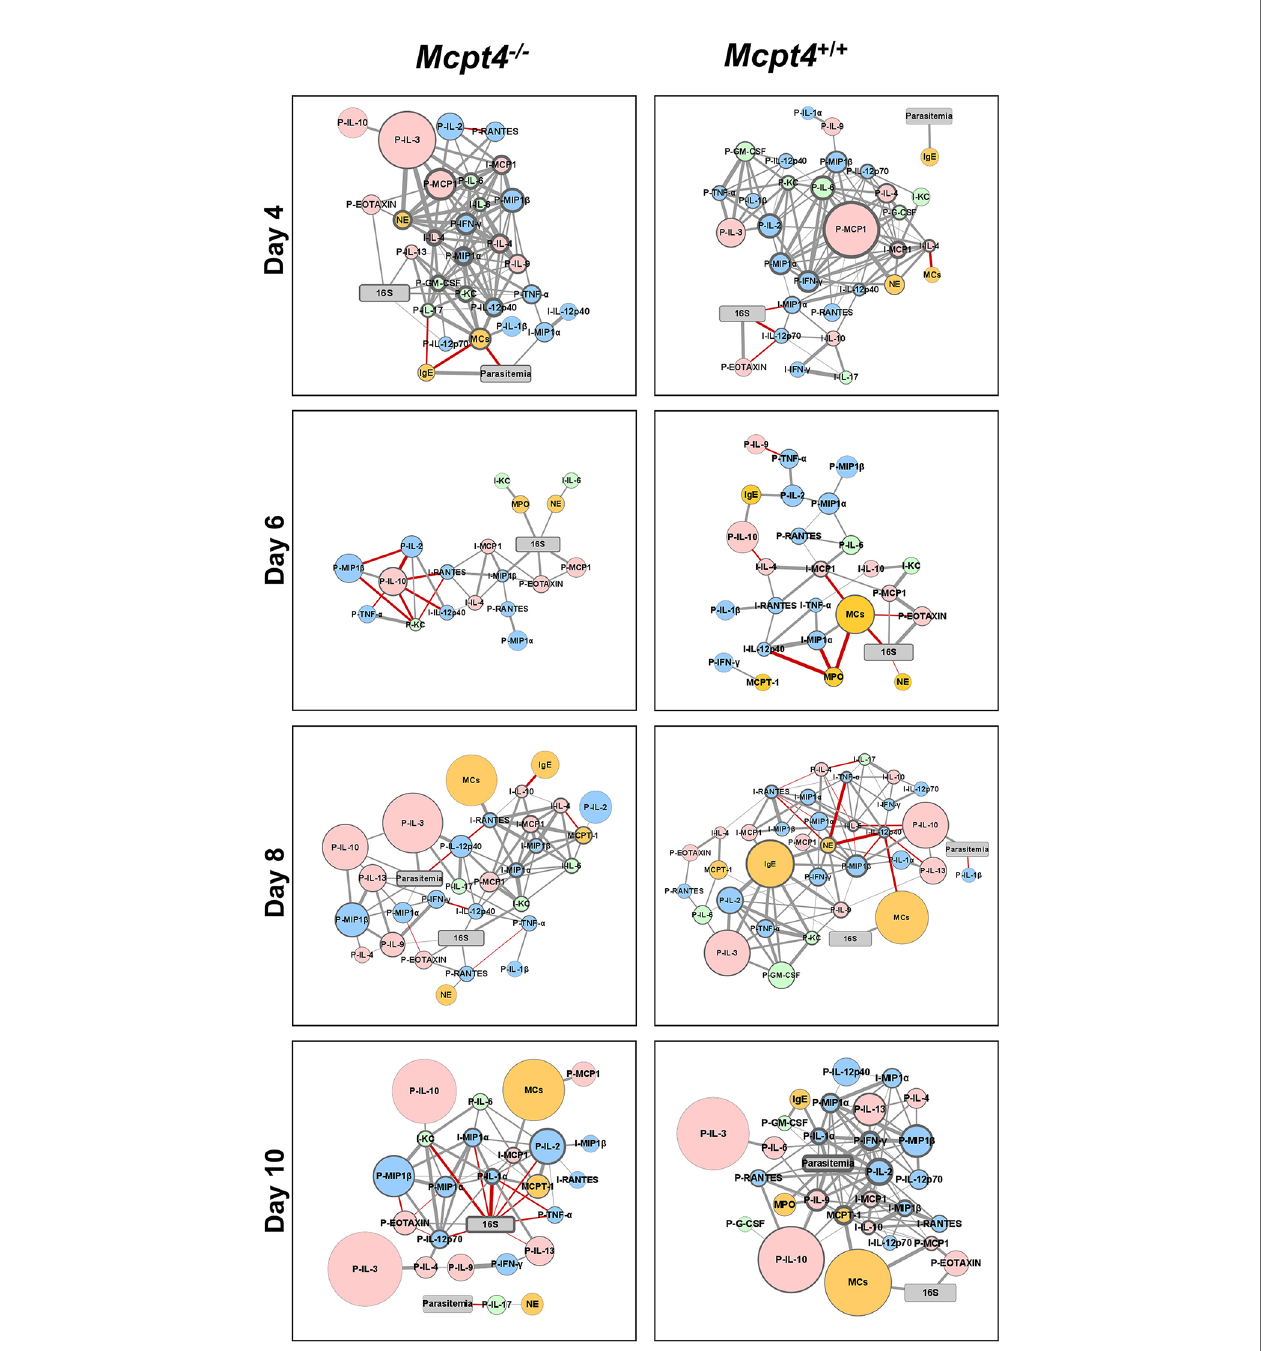
FIGURE 7 | Network visualization of Mcpt4 -/- and Mcpt4 +/+ mouse phenotypes during P. y. yoelii 17XNL infection. Network visualization of signi fi cant correlations ( Figure S3 ) at different times post-infection in Mcpt4 -/- mice (left) and Mcpt4 +/+ mice (right). The size of a circular node represents relative fold change (larger circle = larger fold change) of a parameter calculated as average levels in infected mice/average levels in control uninfected mice. The border width represents the degree or number of connections (the higher the number of connected edges, the thicker the edge). Parasitemia and 16S nodes are presented in gray, blue nodes are pro-in fl ammatory cytokines and chemokines (type-1 immune response), pink nodes are anti-in fl ammatory or regulatory cytokines and chemokines (type-2 immune response), green nodes are type-17 immunity-related cytokines and chemokines, orange nodes represent cells and cells markers (MCs, Mcpt1, MPO and NE). Gray strokes connect nodes with positive correlations and red strokes re fl ect negative correlations. Increasing stroke line width re fl ects increasing Spearman ’ s correlation